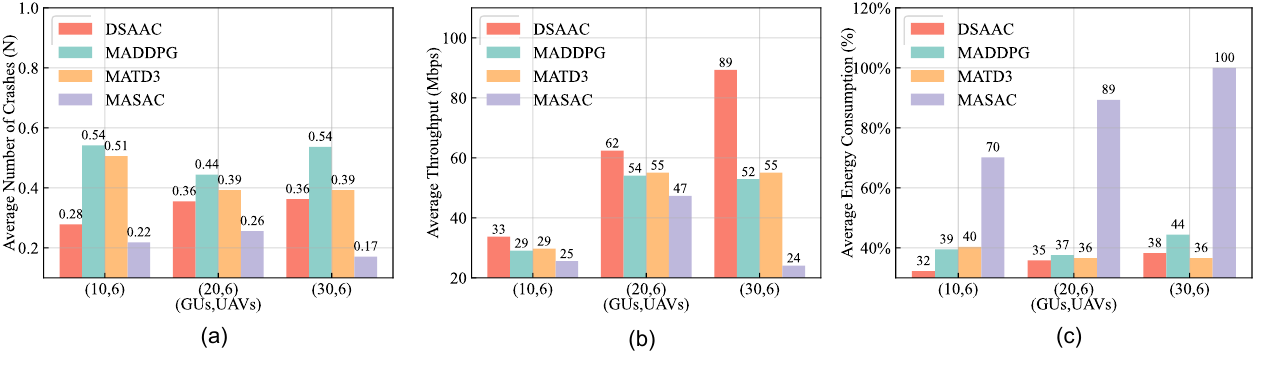
Figure 11. Performance comparison of different number of GUs: ( a ) Average number of crashes; ( b ) Average system throughput; ( c ) Average energy consumption.